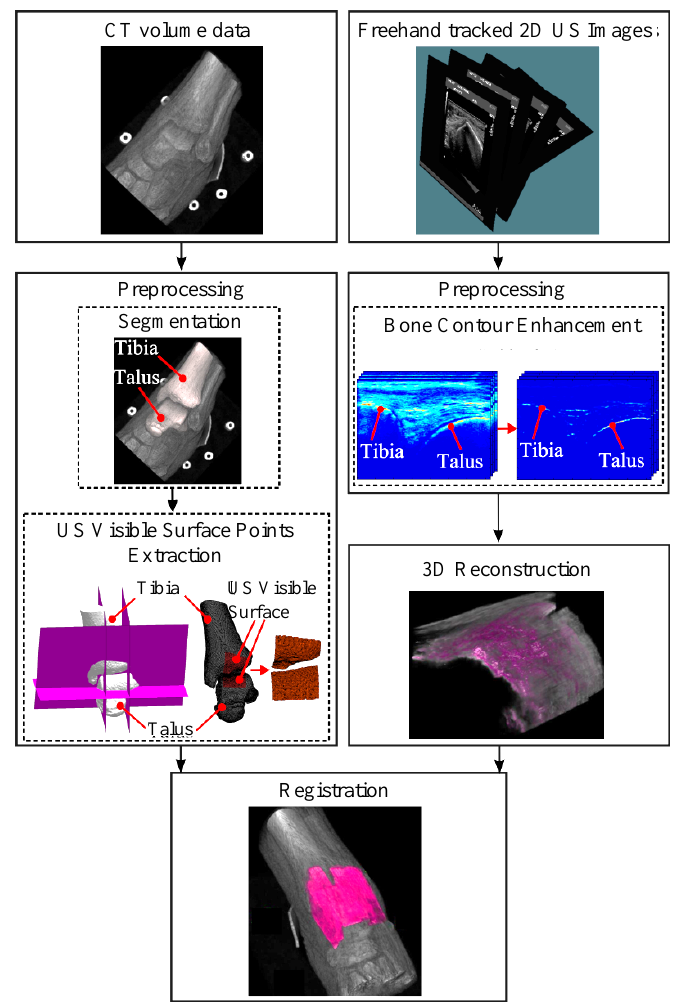
Figure 1. Overview of the rigid surface–volume registration scheme to match computed tomography (CT) and ultrasound (US) images of the talocrural joints. CT and US images are pre-processed before the registration. During the pre-processing step, surfaces of bones (i.e., tibia and talus) that can be visualized with US in maximal-plantar flexed ankle are extracted from the CT image and bone contours in freehand tracked 2D US images are enhanced using intensity invariant local-phase based approach and bone shadow information. The 3D bone response data is reconstructed from 2D enhanced US images using the position of the US probe that had been recorded with an optical tracking system. Registration is initialized at a location defined using the position of the six fiducials in the US and CT spaces.